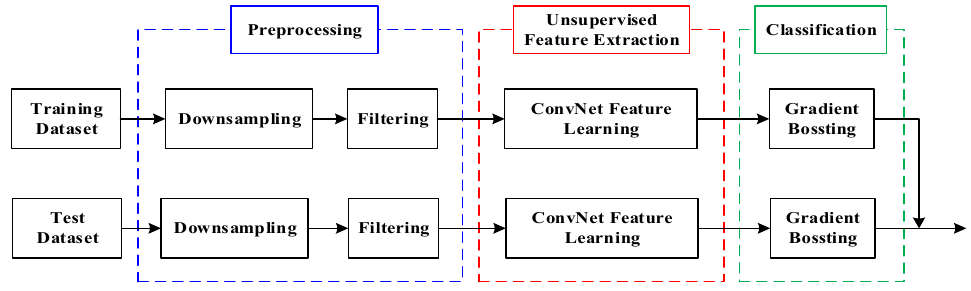
Figure 3. The architecture of the proposed ECoG-based BCI system.